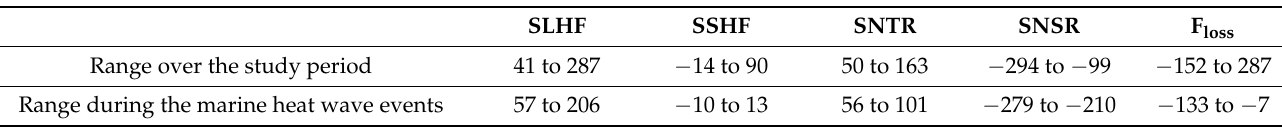
Table 2. Range of the sea surface radiation budget components over the study period and during marine heat wave events (all values are in W m − 2 ). SLHF SSHF SNTR SNSR F loss Range over the study period 41 to 287 − 14 to 90 50 to 163 − 294 to − 99 − 152 to 287 Range during the marine heat wave events 57 to 206 − 10 to 13 56 to 101 − 279 to − 210 − 133 to −